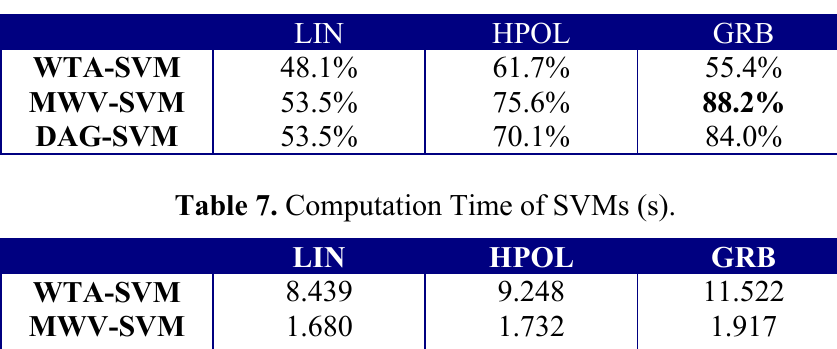
Table 6. Classification Accuracy of SVMs.